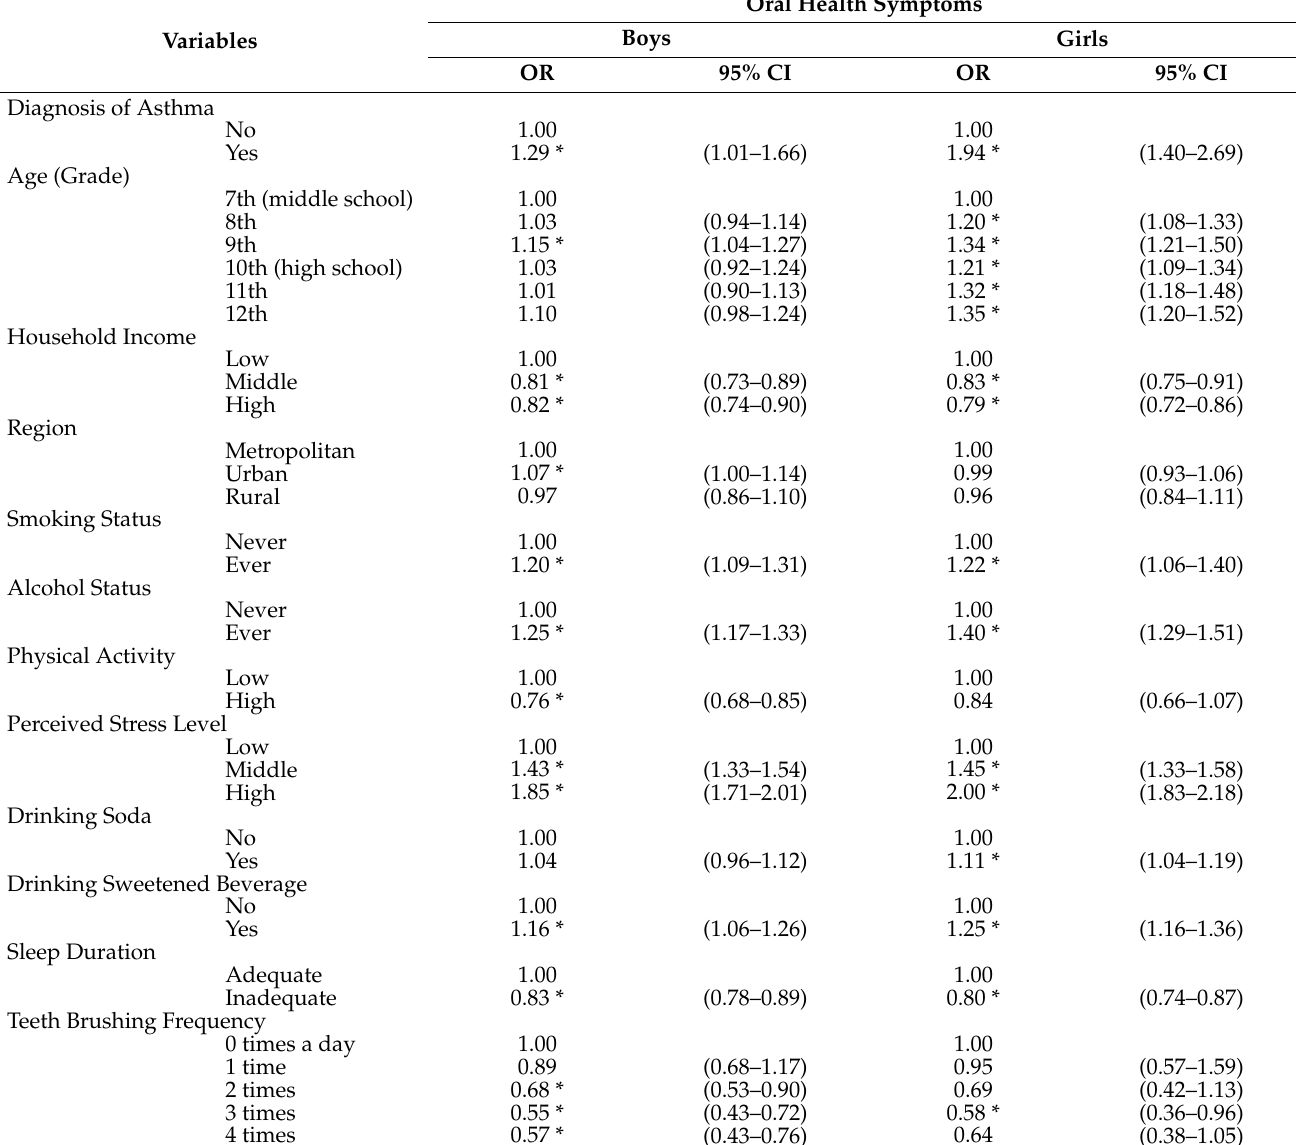
Table 2. Results of factors associated between asthma and oral health